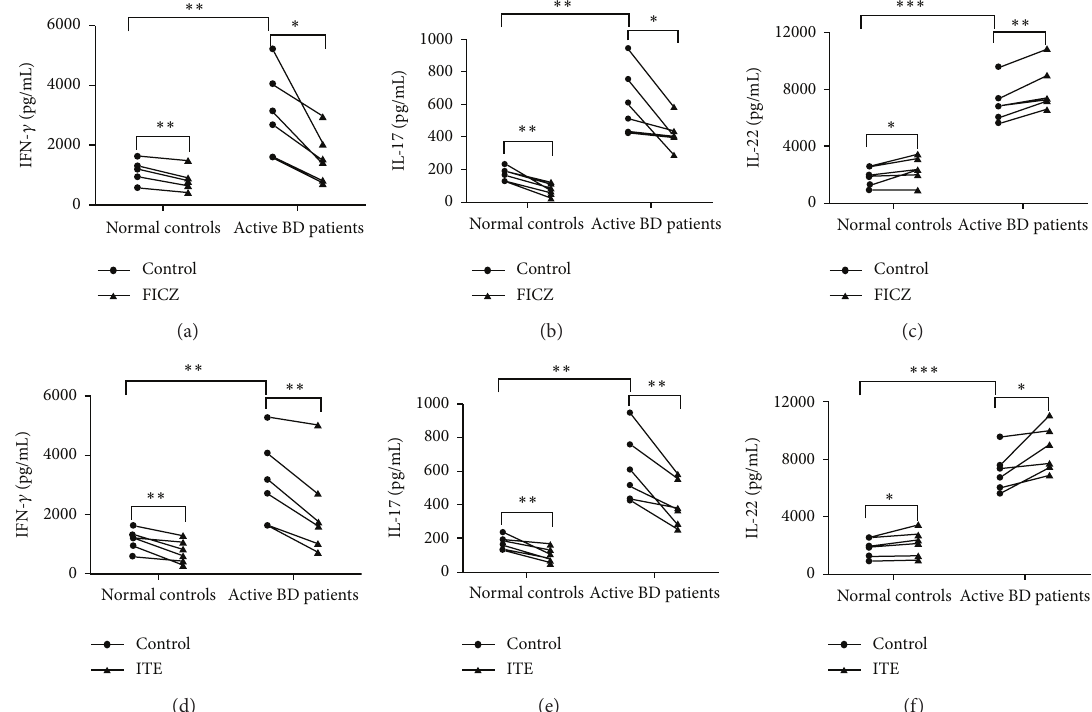
Figure 3: FICZ and ITE inhibit IFN- 𝛾 and IL-17 but induce IL-22 expression by CD4 + T cells from BD patients and normal controls. Purified CD4 + T cells from active BD patients ( 𝑛 = 6 ) and normal controls ( 𝑛 = 6 ) were stimulated with anti-CD3/CD28 and rIL-23 in the presence or absence of FICZ (100nmol/L) or ITE (100nmol/L) for 6 days. IFN- 𝛾 (a and d), IL-17 (b and e), and IL-22 (c and f) production in the supernatants were determined by ELISA. Paired-sample t test or Wilcoxon’s matched-pairs test for related samples and Independent-Sample t test for independent samples were used for statistical analyses. ∗ 𝑃 < 0.05 , ∗∗ 𝑃 < 0.01 , and ∗∗∗ 𝑃 < 0.001 .